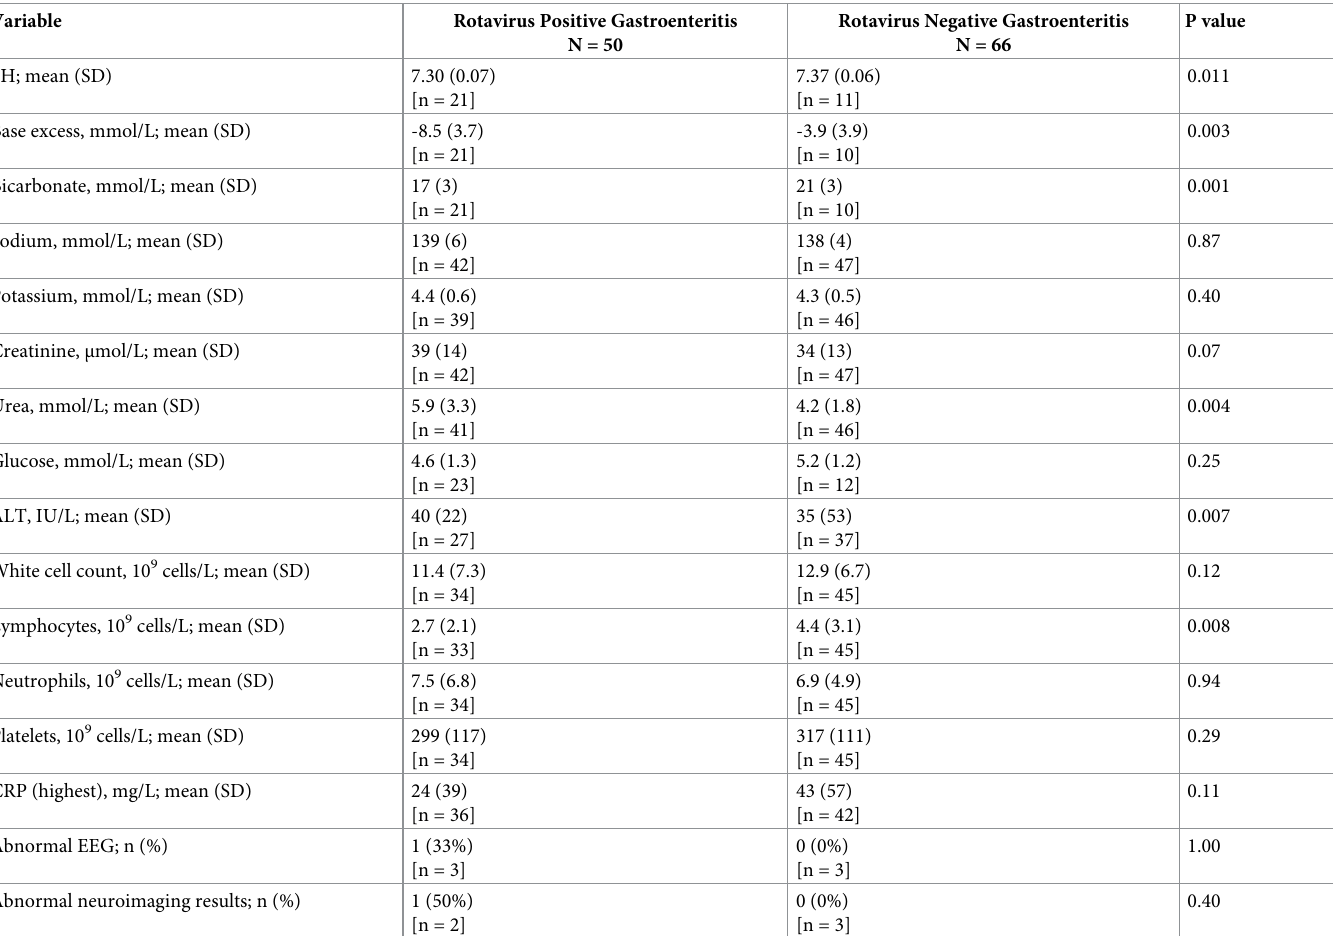
Table 3. Laboratory results of children with rotavirus-positive and rotavirus-negative